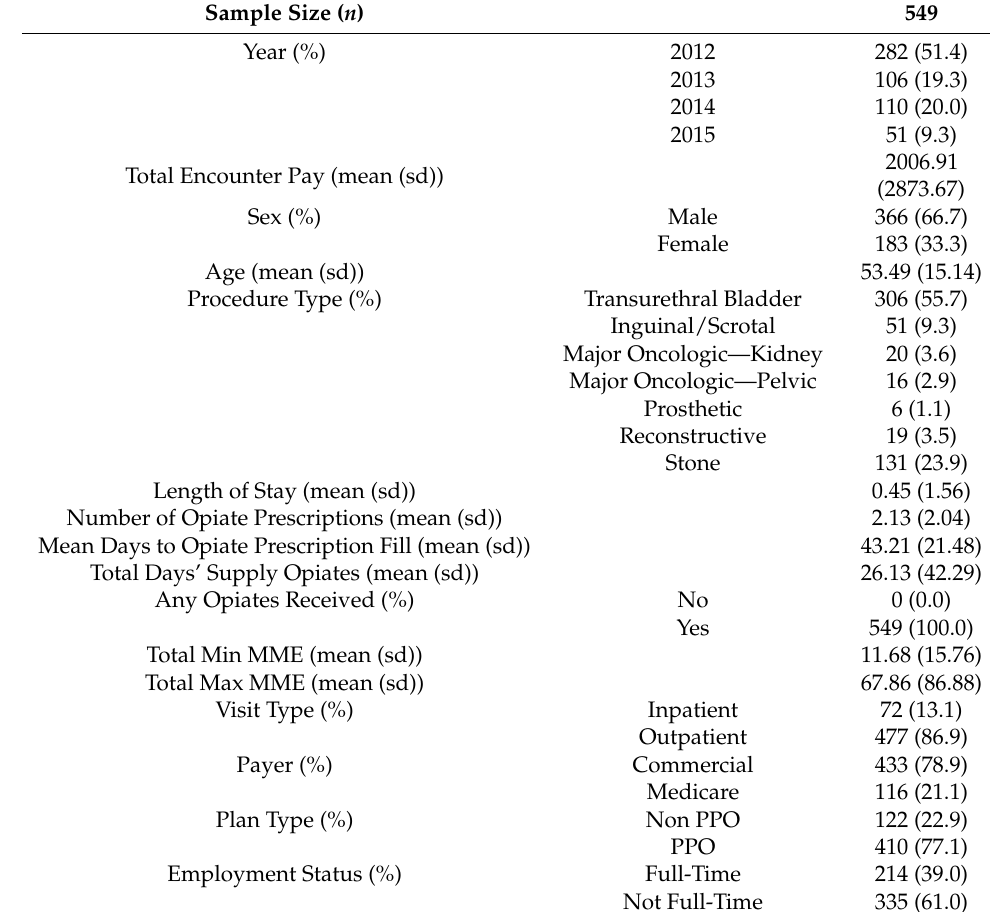
Table 2. Baseline characteristics of the population of encounters receiving